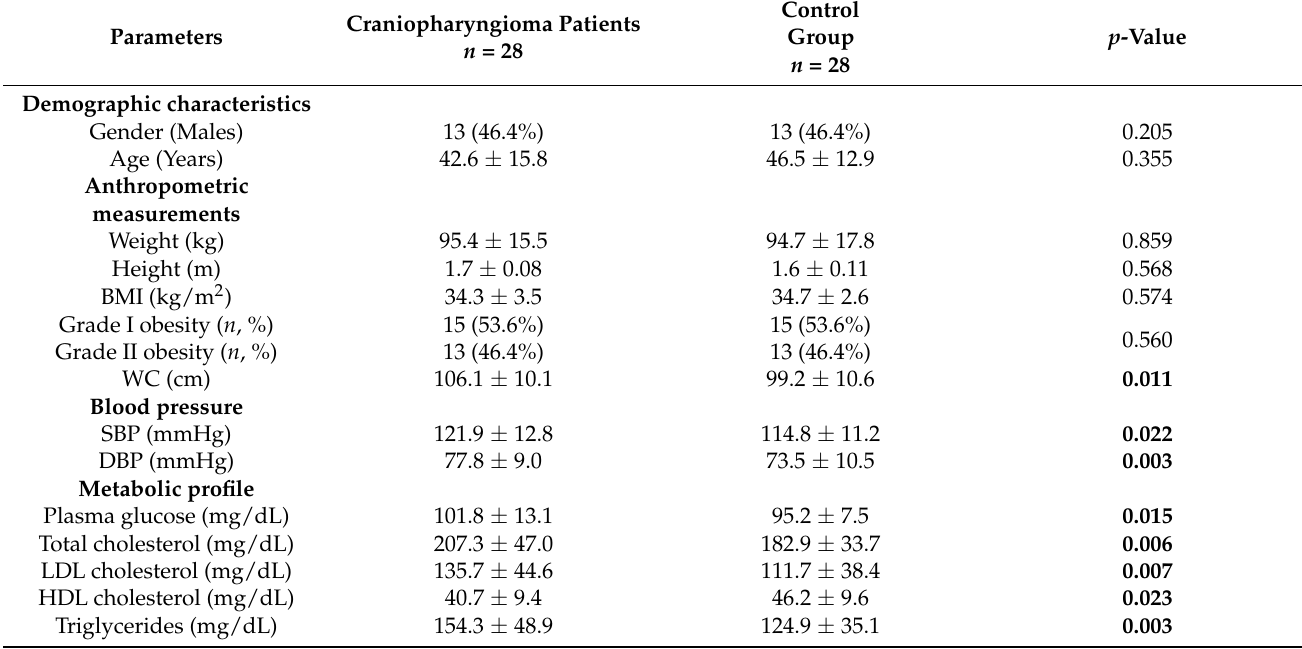
Table 2. Differences in study parameters between patients with craniopharyngioma and control